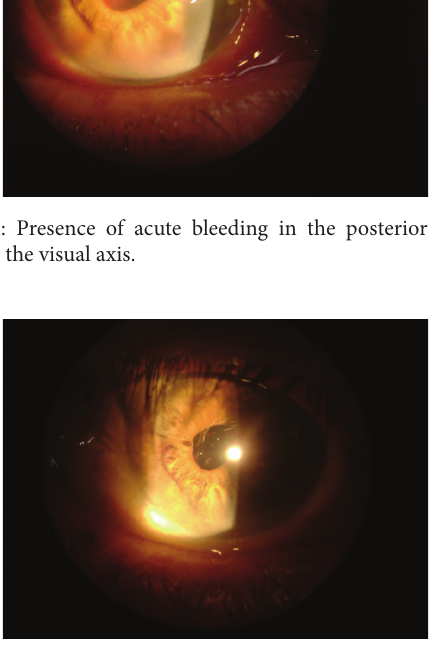
Figure 2: After 24 hours complete reabsorbtion of blood with total visual